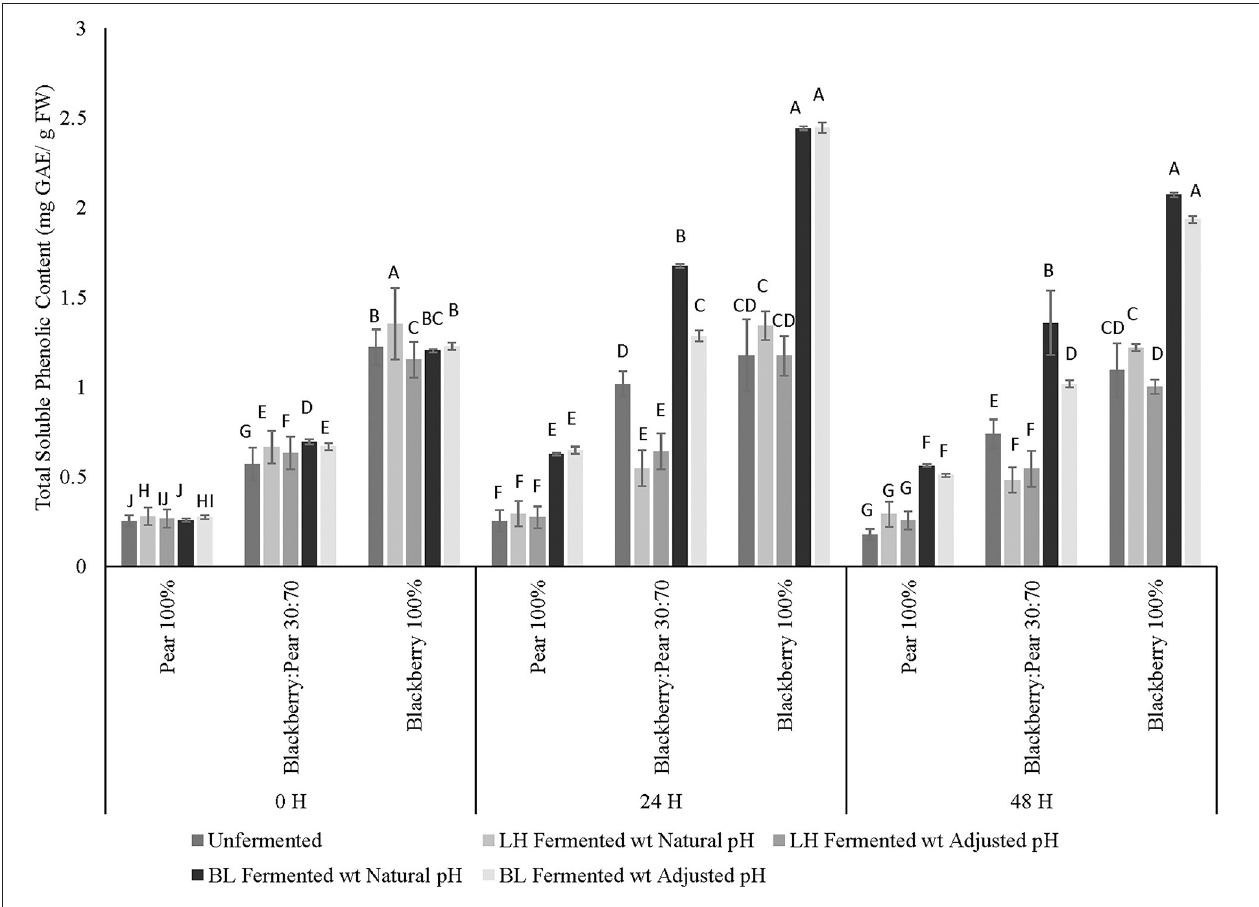
FIGURE 1 | Total soluble phenolic content (mg GAE/ g FW) of Bartlett pear (100%), blackberry: pear (30:70), and Kiowa blackberry (100%) after fermenting with Lactobacillus helveticus (LH) and Bifidobacterium longum (BL) at 0, 24, and 48h time points. Different uppercase letters represent statistically significant ( p ≤ 0.05) differences in TSP content between fruit sample extracts × fermentation treatment interactions separately at all 3 fermentation time